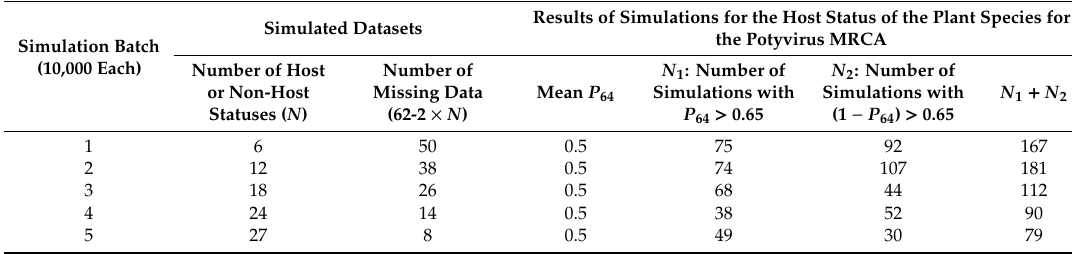
Table A1. Summary results of